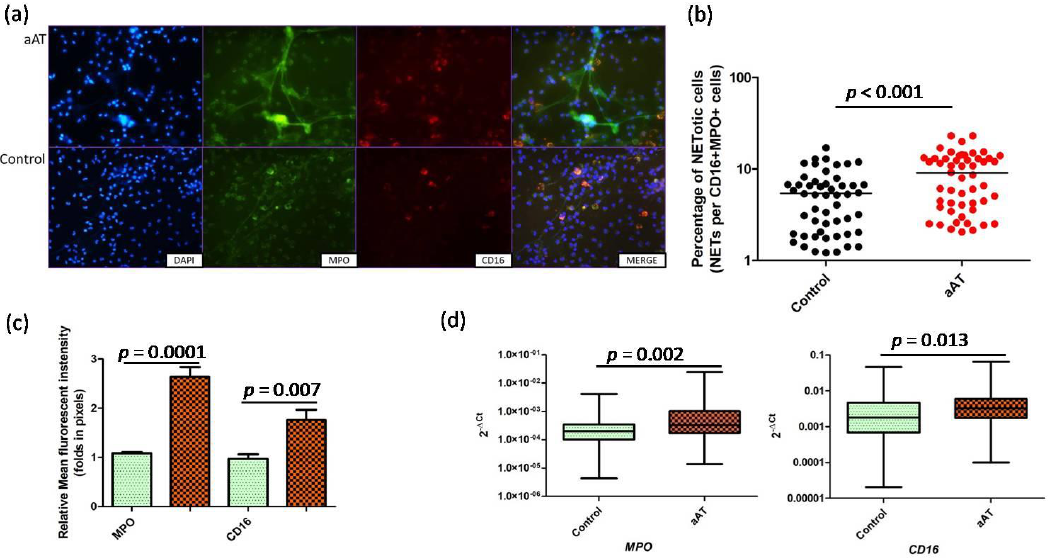
Figure 2. ( a ) Effect of IL-33 on in vitro neutrophil extracellular trap (NET) formation potential of MPO (myeloperoxidase) + neutrophils in aAT patients and controls (MPO = green, CD16 = red, and nucleus = blue (DAPI counterstain)); ( b ) quantification of NETotic cells (right); ( c ) quantification (relative mean fluorescent intensity) of MPO and CD16 proteins; ( d ) MPO and CD16 transcript expression in IL – 33 – treated neutrophils of aAT patients and controls.